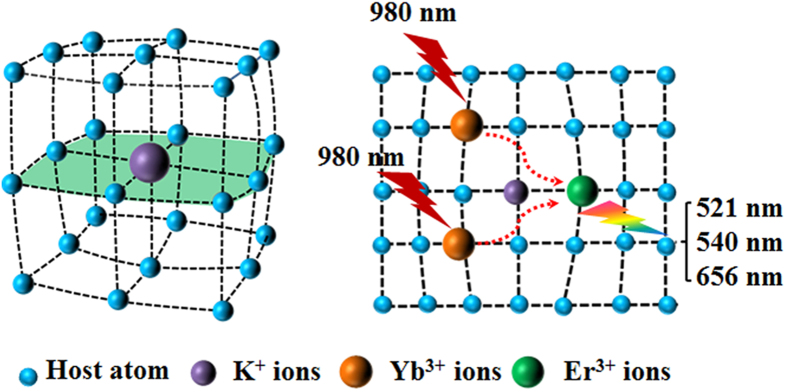
The possible change in the β- NaYF4 crystal lattice after K+ ions doping.